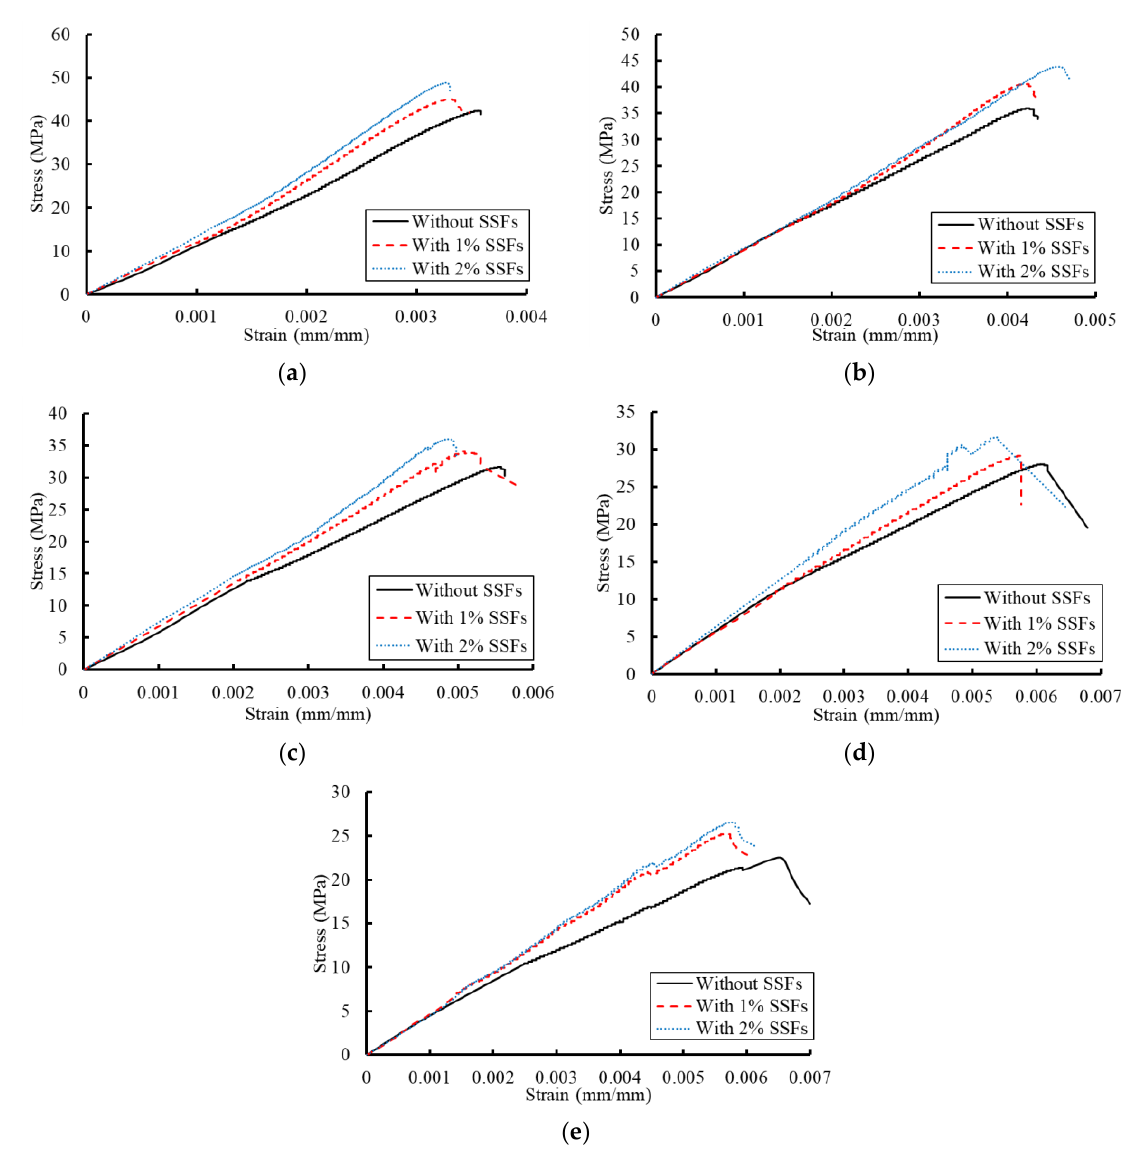
Figure 12. Effect of SSFs on the stress–strain relationships of rubberized concrete. ( a ) 0% content of CR. ( b ) 5% content of CR. ( c ) 10% content of CR. ( d ) 15% content of CR. ( e ) 20% content of CR.